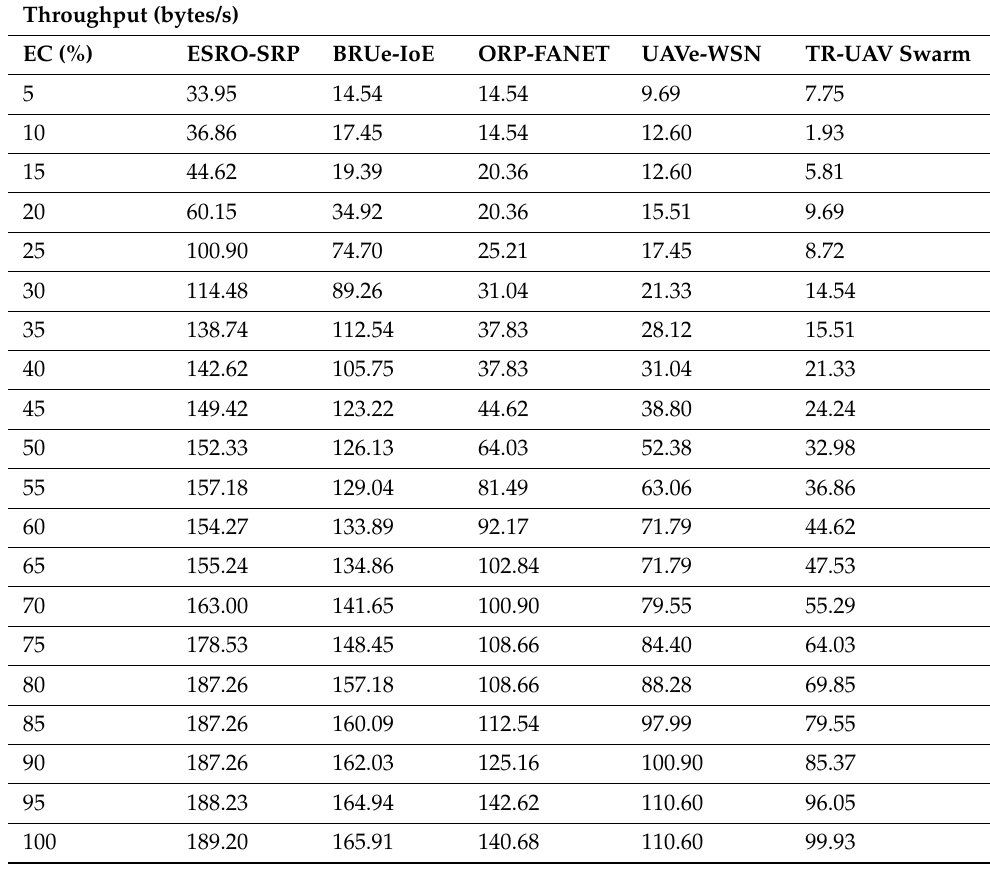
Table 1. Throughput analysis of ESRO-SRP technique with existing algorithms under distinct levels of